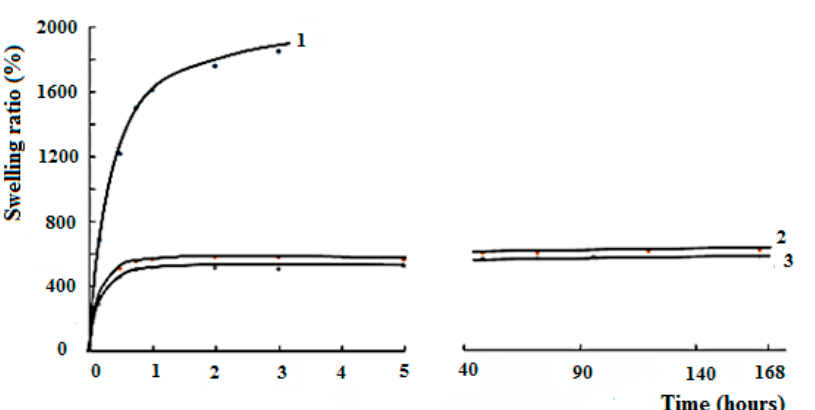
Figure 6. Swelling kinetics of chitosan hydrochloride/apple pectin hydrogels in distilled water (1); PBS (pH = 7.4) (2); saline solution (3). Data are expressed as mean ± SD; n = 3.